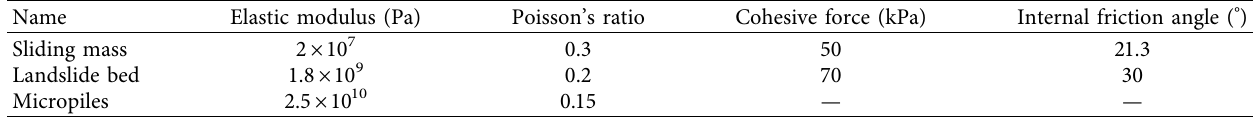
Table 1: Numerical simulation mechanical parameters.